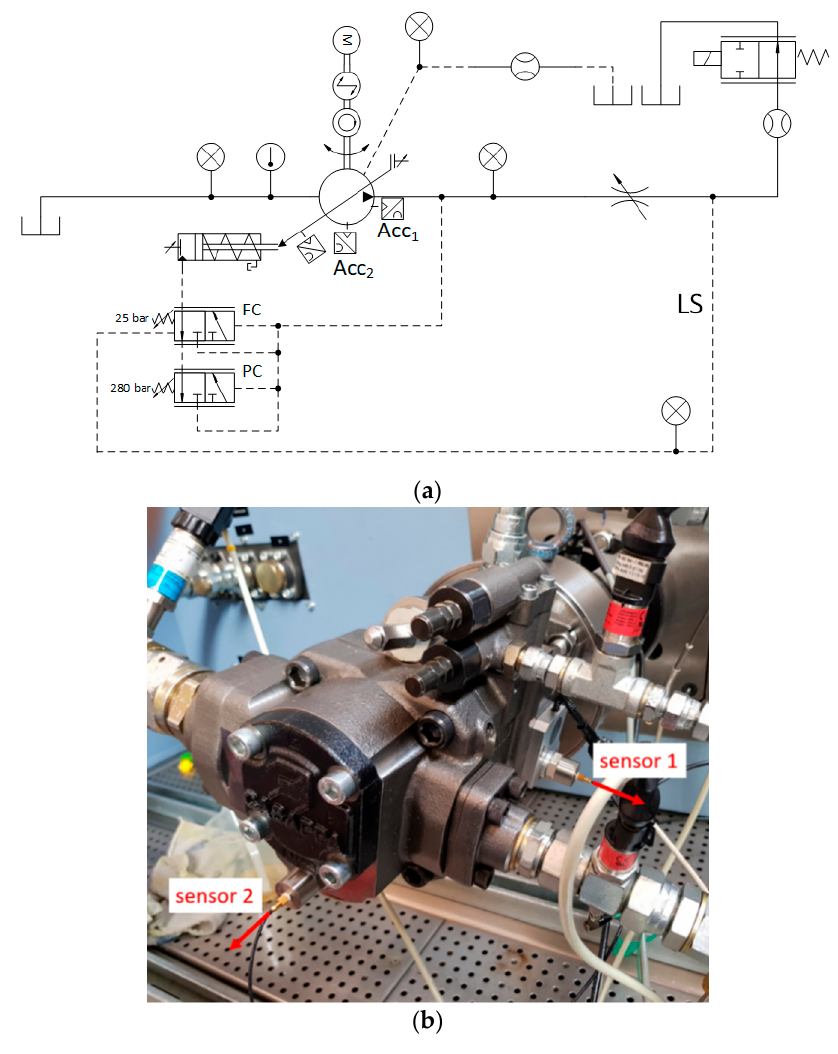
Figure 2. ( a ) Hydraulic scheme of the experimental layout; ( b ) Position of the two accelerometers on the pump.